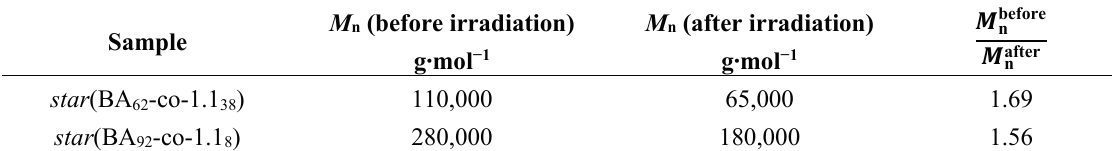
Table 2. Apparent number of average molecular weights reflecting the hydrodynamic volume before and after the cross-linking with 100 W for star (BA- co - 1.1 ) samples containing various cross-linking group (DMI)